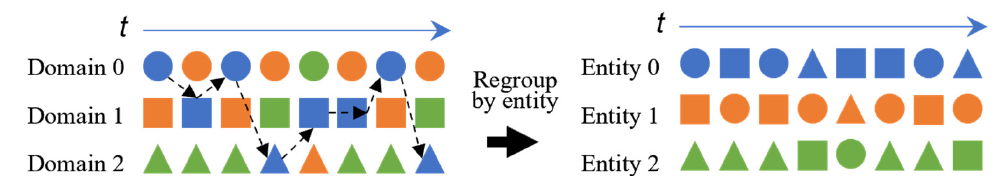
Figure 2. Approach to generate event sequences: domains are used to distinguish different hosts, colors are used to distinguish different entities (i.e., users), and shapes are used to distinguish different events. The left side of the figure represents the time-ordered event sequence of the same event generated by different entities in the same domain (i.e., hosts). After data reorganization, the right side of the figure represents the time series of different events generated by the same entity, sorted by time, that is, the entity-level cross-domain event sequence.